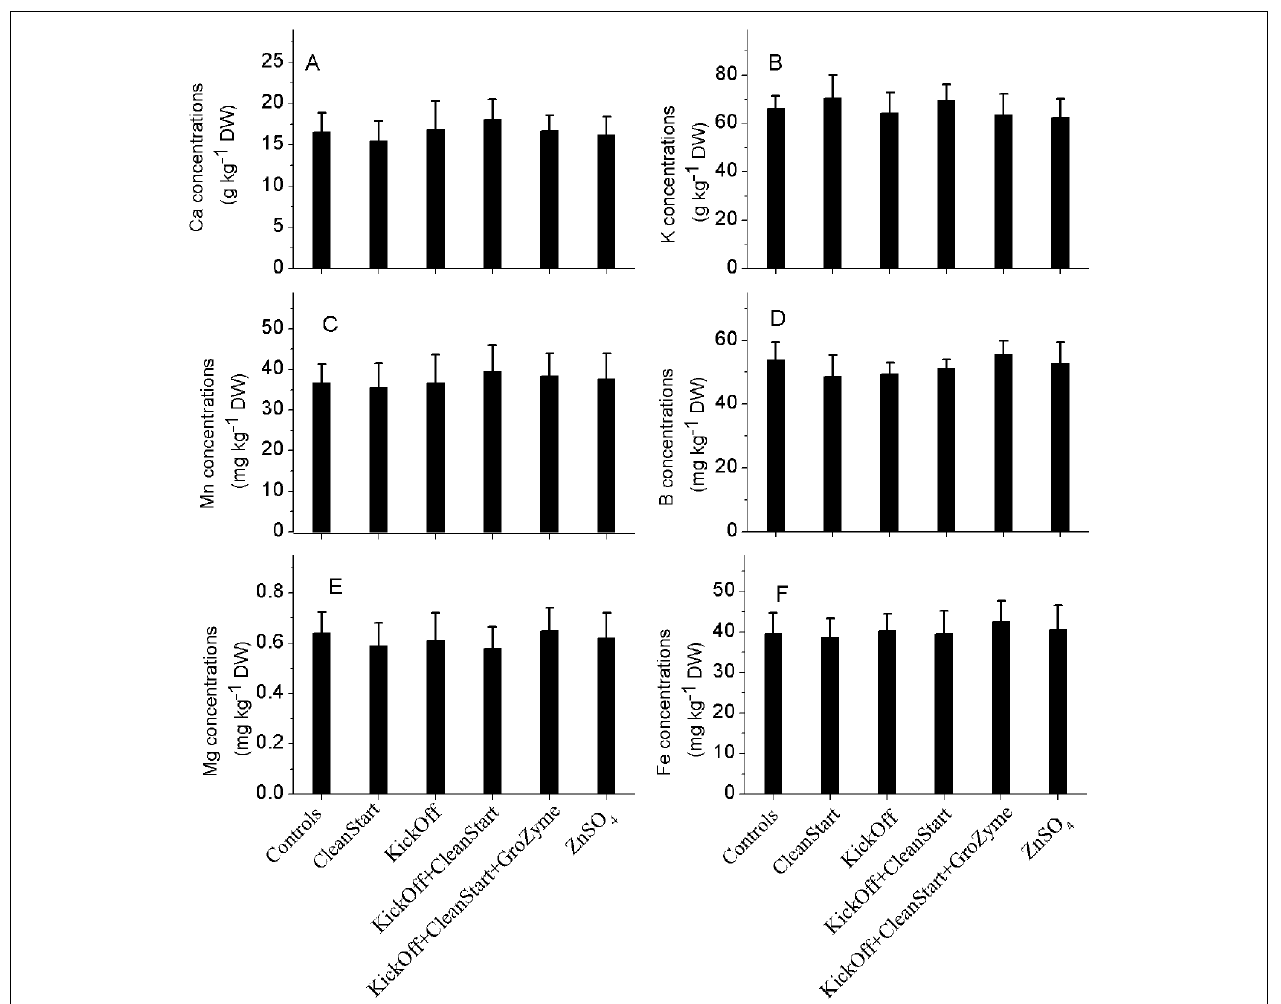
FIGURE 6 | Concentrations of Mn, Mg, B, Fe (mg kg –1 DW), and Ca, K (g kg –1 DW) in the petioles collected from sunflower plants treated with different foliar fertilizers. Full expanded leaves of sunflower were treated with control, CleanStart, Kick-Off, CleanStart + Kick-Off, CleanStart +